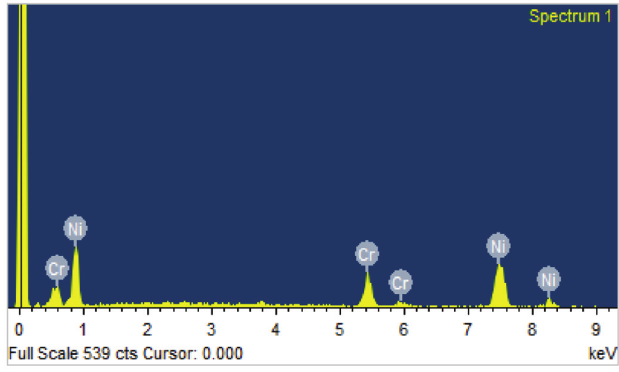
Fig. 2. EDAX Report of nickel coating